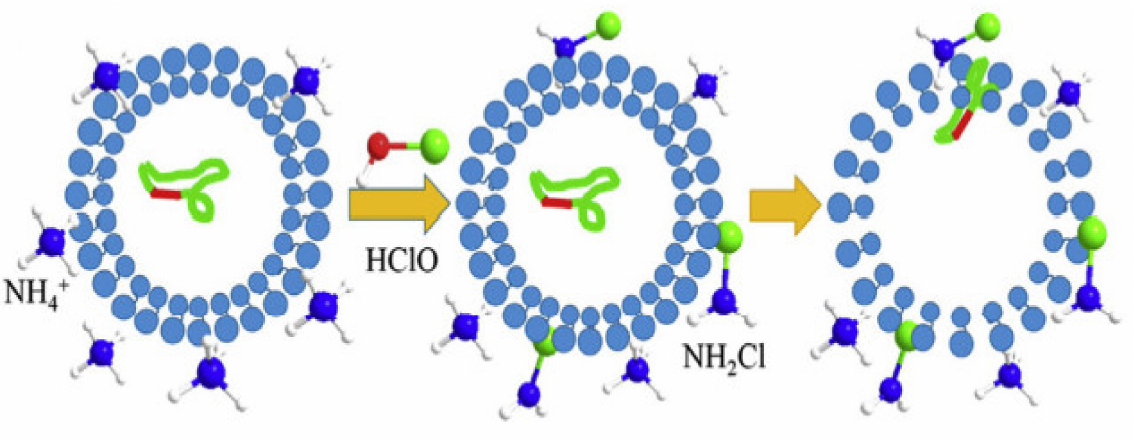
Figure 3. Mechanisms of chlorination disinfection affecting ARG conjugation and transfer (adapted from Guo et al.